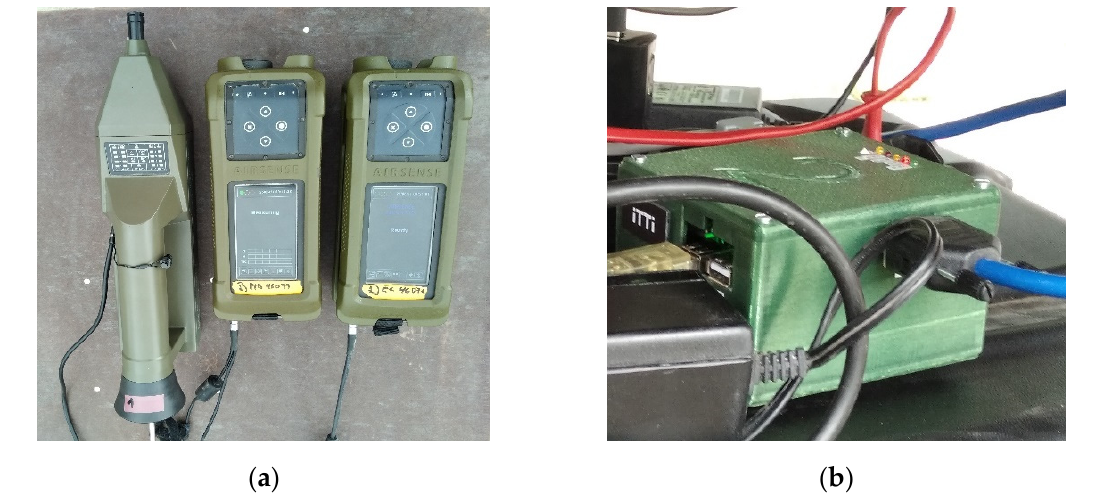
Figure 2. EU-SENSE system prototype. ( a ) EU-SENSE detection tool; ( b ) Sensor node.